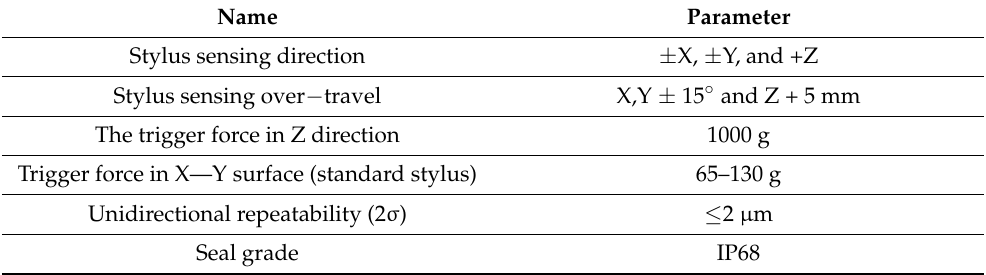
Table 2. Technical parameters of PIONEER TP300 series of cable probe.